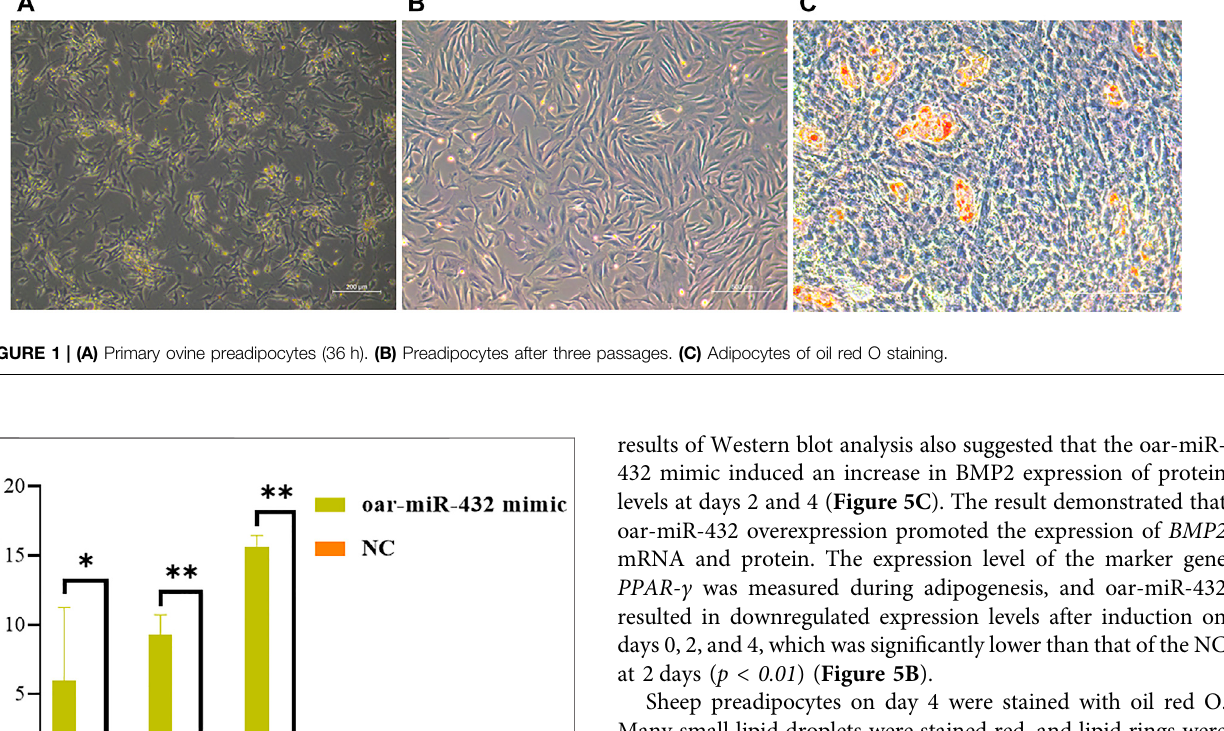
Frontiers in Genetics |